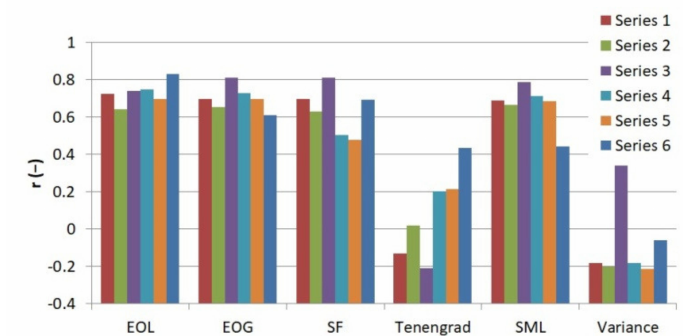
Figure 7. Comparison of coefficients of correlation between the values of sharpness measures (functions V (cid:48) = f( α ) and V (cid:48) = f( d )) and the observers’ indications for every series of thermograms and each measure of sharpness, where V’—standardized value of sharpness measures, α —angle of focusing ring placed on the thermographic camera lens, d —distance between the thermographic camera lens and observed object.